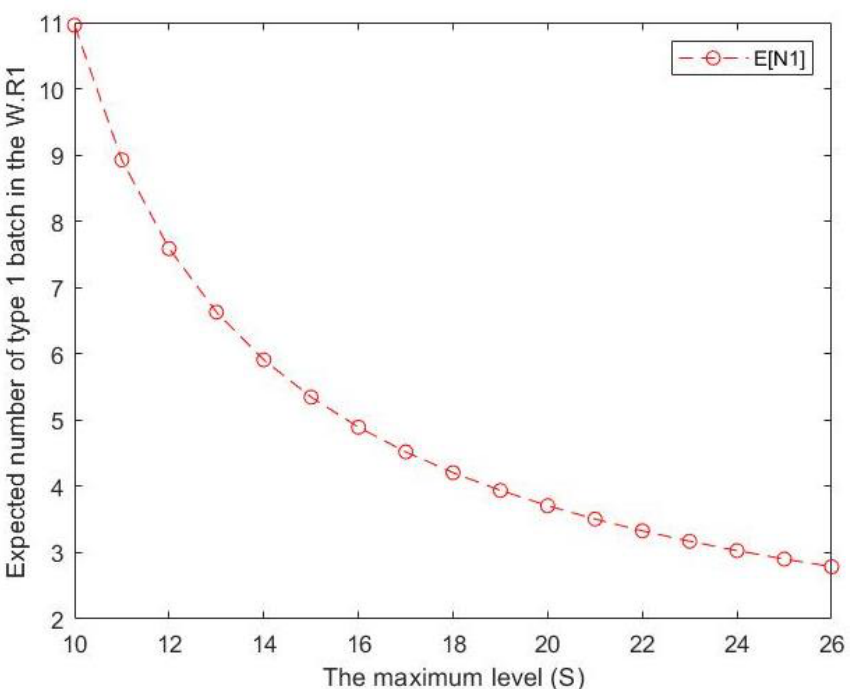
Figure 3. Effect of S on expected number of type 1 customers in the waiting room for type 1.